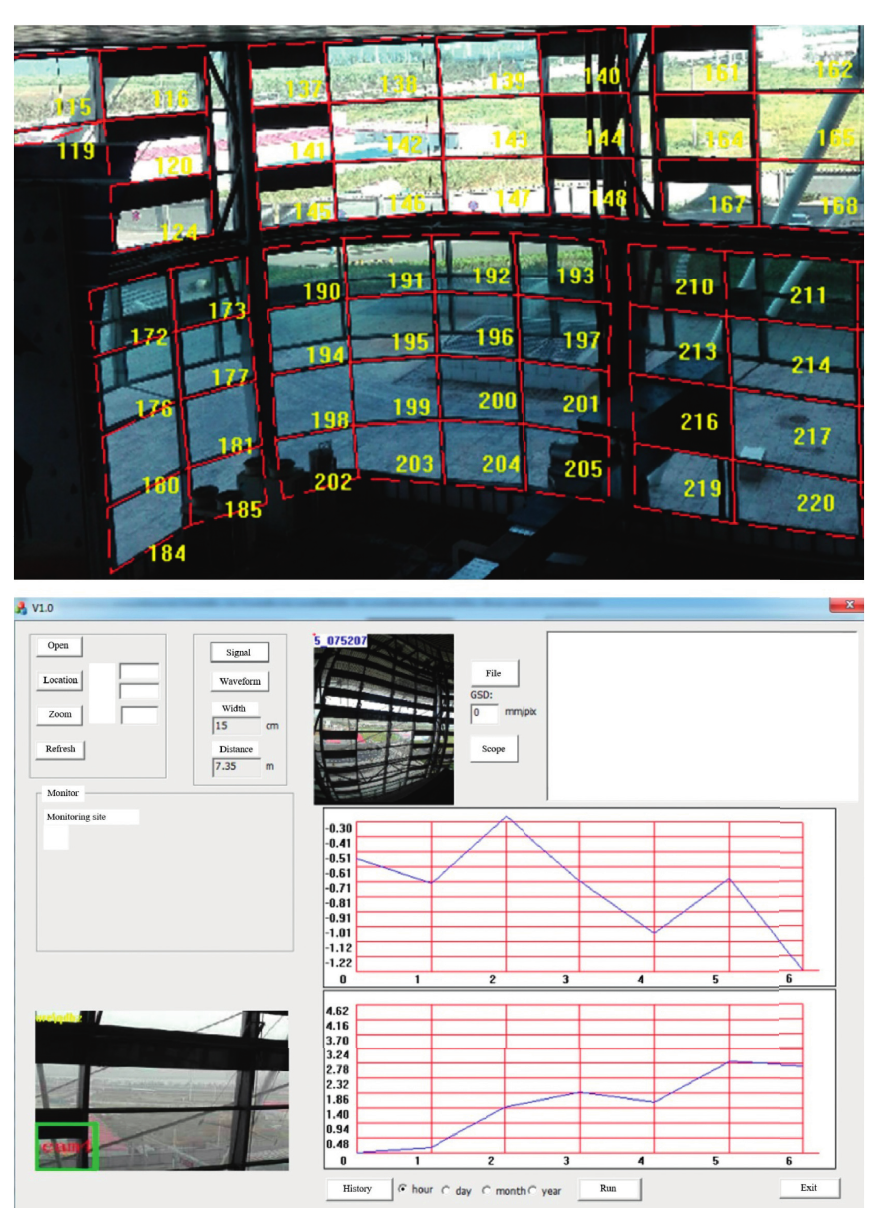
Figure 12: Deformation monitoring of the glass curtain wall at Qingdao North Station.